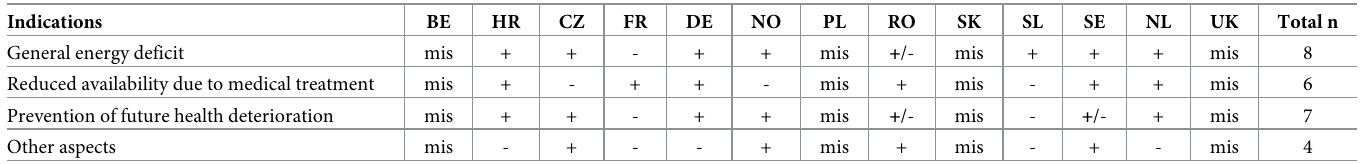
Table 2. Indications to limit work endurance in European countries (n = 13).